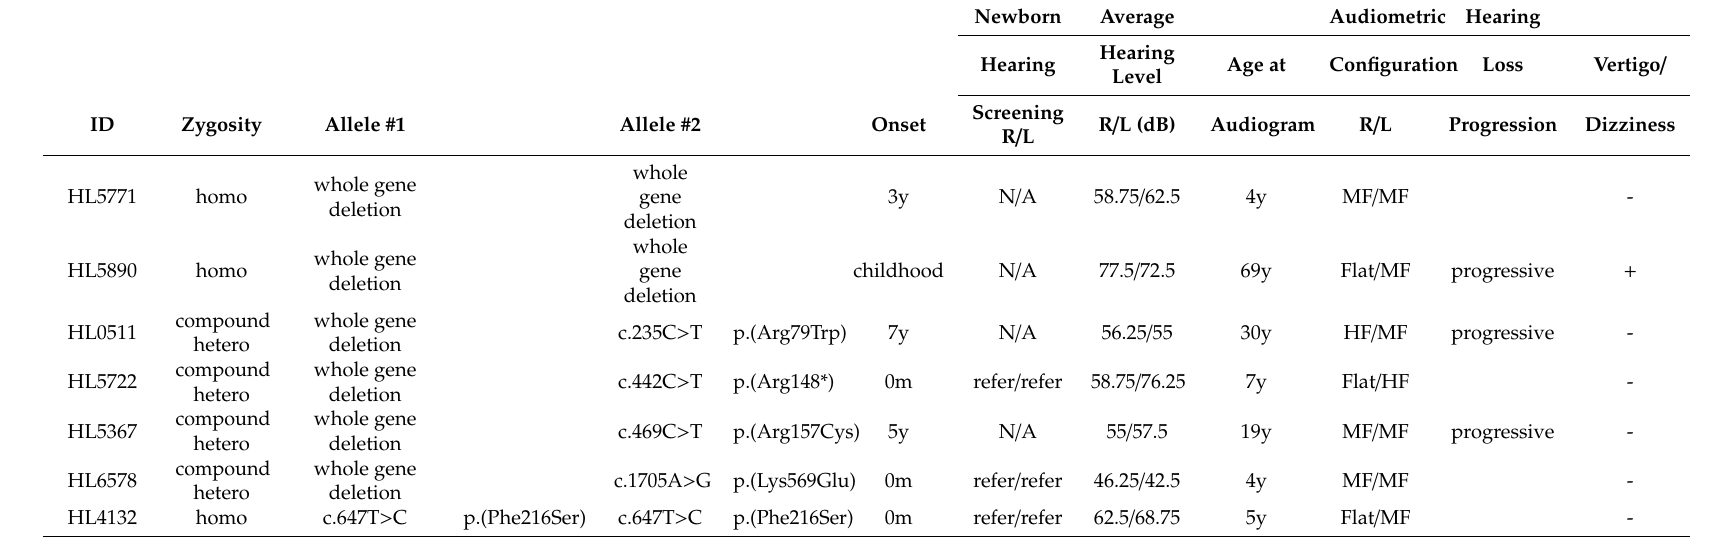
Table 1. Summary of the clinical features and identified variants of individuals with OTOA variants in this